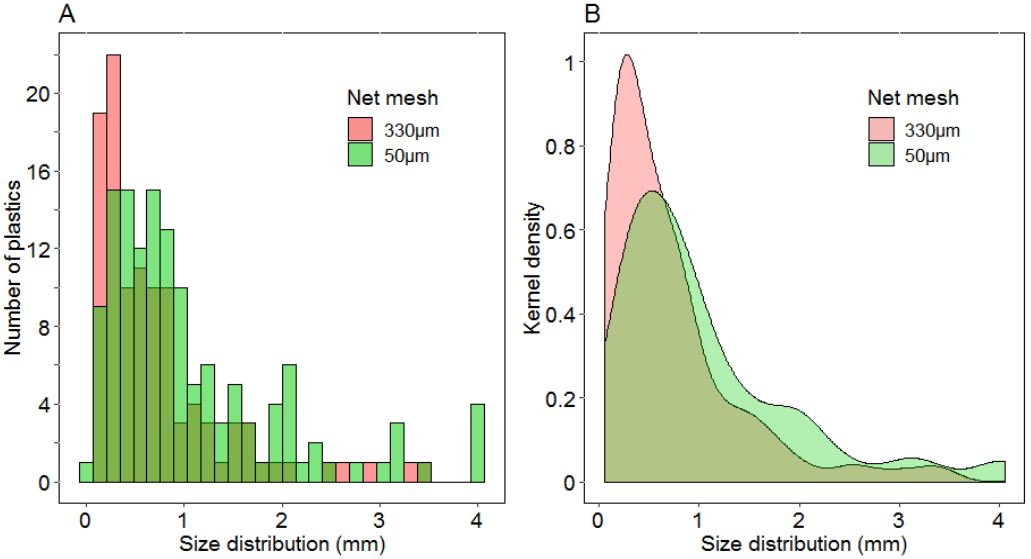
Figure 6. Size distribution ( A ) and kernel density ( B ) for plastic samples collected by 50 µm and 330 µm pore size